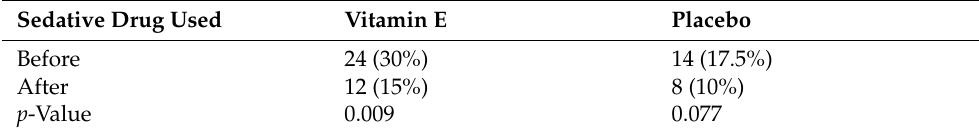
Figure 2. Boxplot of the PSQI score before and after intervention between the two groups. Table 3. Sedative drug use in each group. Table 3. Sedative drug use in each group.